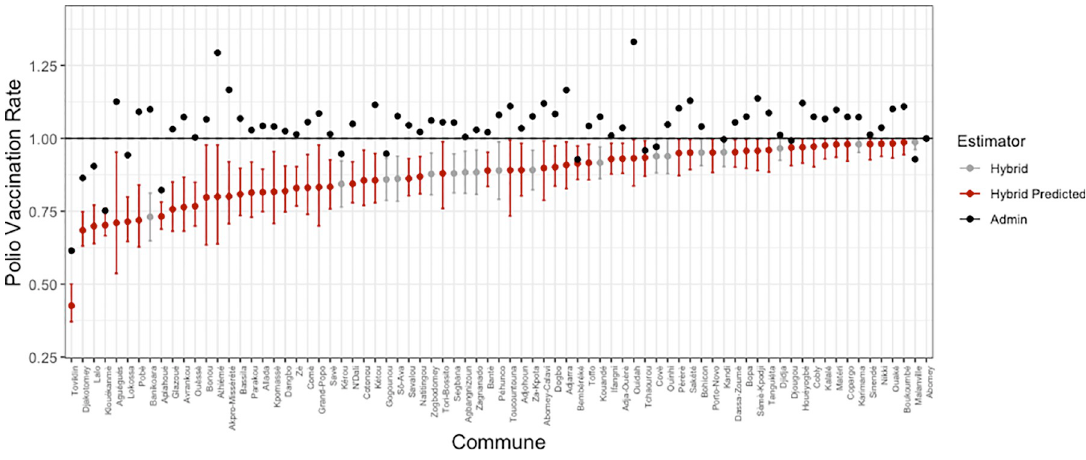
Fig 3. Bayesian estimates of polio vaccination rates by